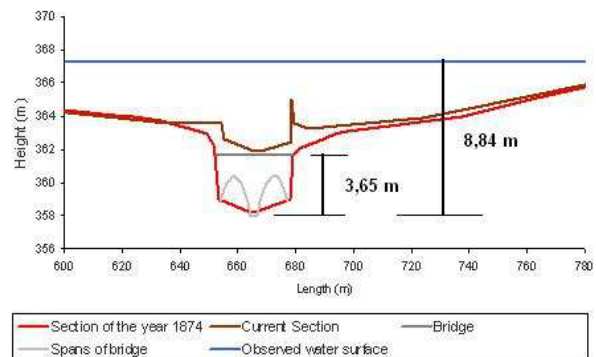
Fig. 7. Present-day (brown line) and 1874 (red line) cross-sections of the Ondara River at Sant Agust ´ ı Bridge (and the eponymous street), with the indication of the maximum water level (blue line) reached by the Santa Tecla flood.